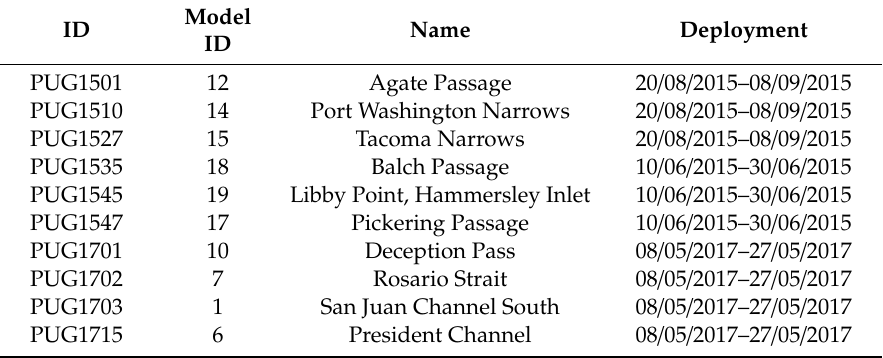
Table A1. Measurements for model verification. Location of these stations are shown in Figure 1.